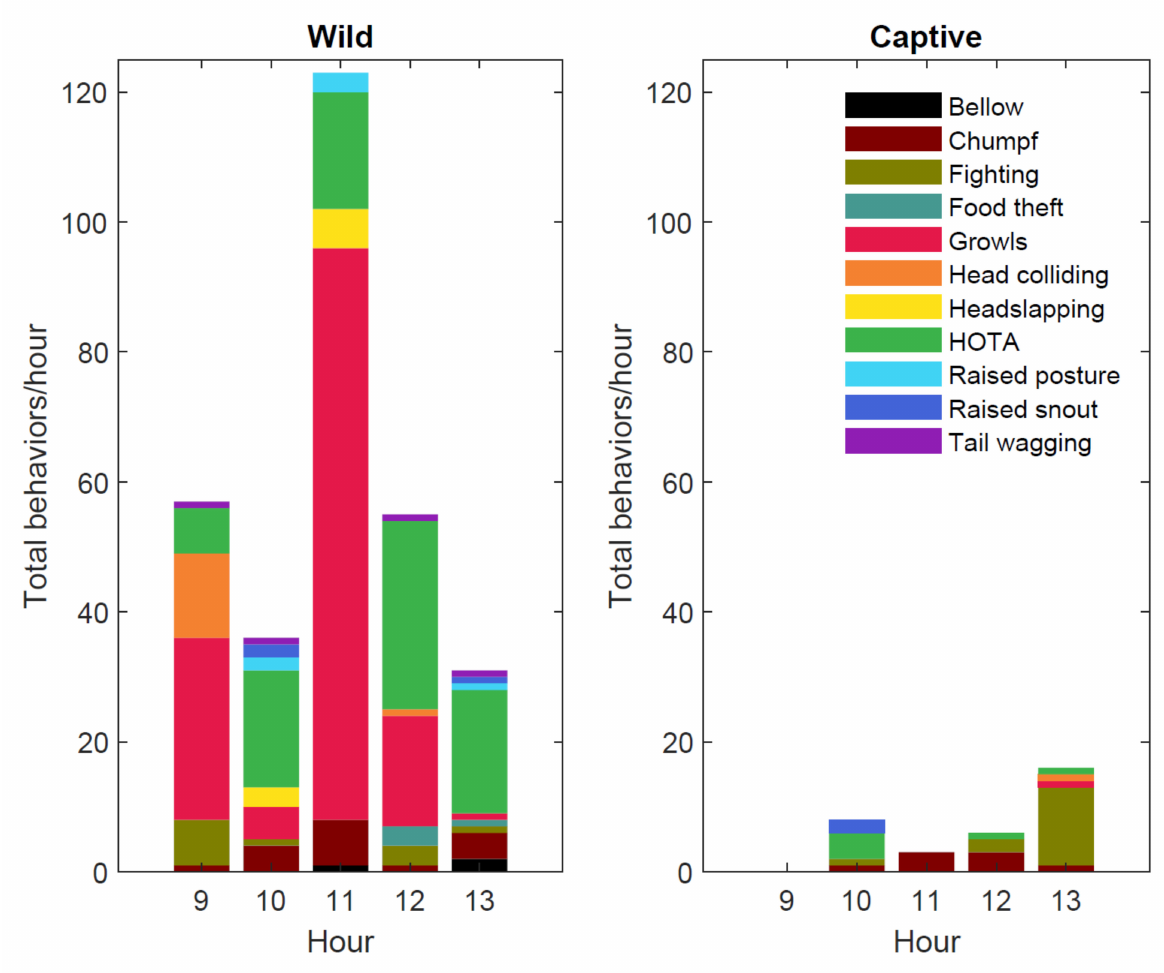
Figure 3. Total number of specific social behaviors (color-coded) during each hour of the day summed across days. The social behavior of the wild congregation is represented on the left and the social behavior of the captive congregation on the right. The y -axis limits are the same for both plots to facilitate comparison of the frequency of social behaviors between the wild and captive